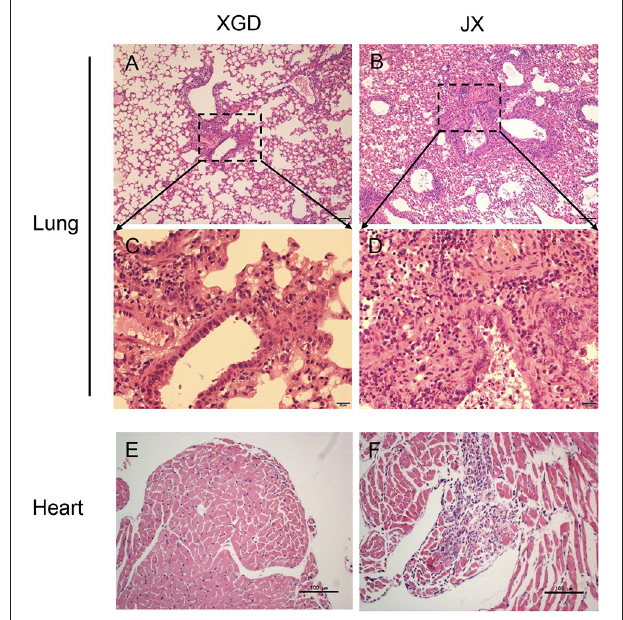
FIGURE 4 | Histopathological analysis of the lungs and hearts of mice infected with the XGD and JX strains of H5N6. Groups of mice ( n = 6) were intranasally infected with 10 5 TCID 50 of XGD or JX. Samples were collected at 5 days post-infection (dpi). Histopathological changes in mouse lungs (A–D) and hearts (E,F) induced by XGD or JX infection. Scale bar in (A,B,E,F) 100 µ m; in (C,D) 20 µ m.